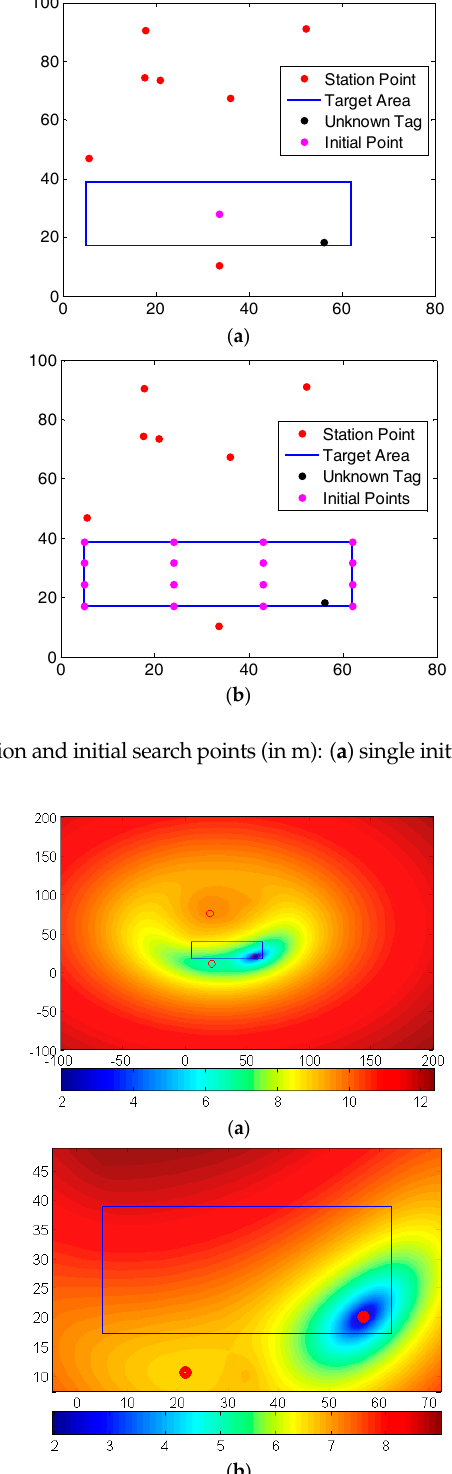
Sensors 2017 , 17 , 2869 9 of 17